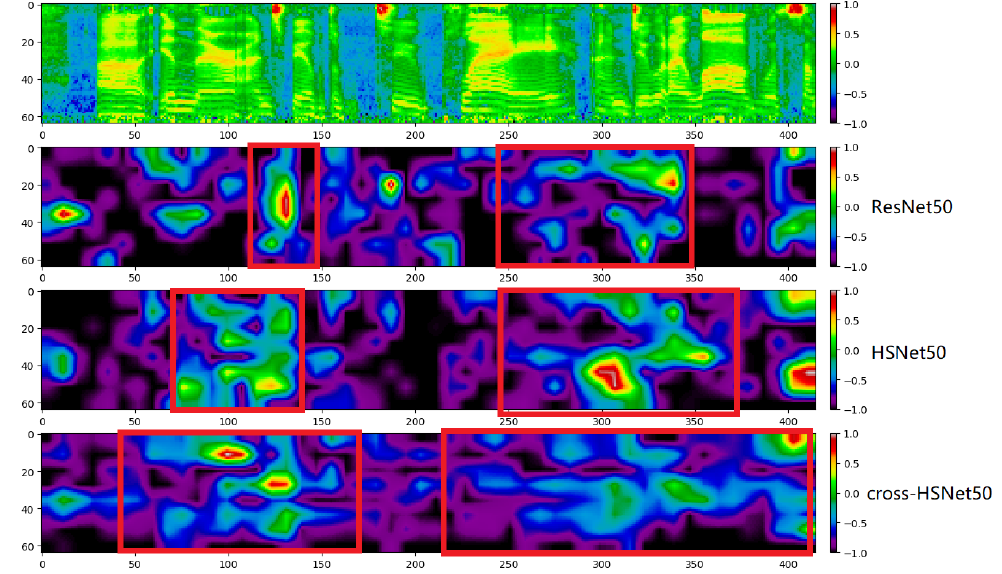
Figure 6. CAM heatmaps for three methods.